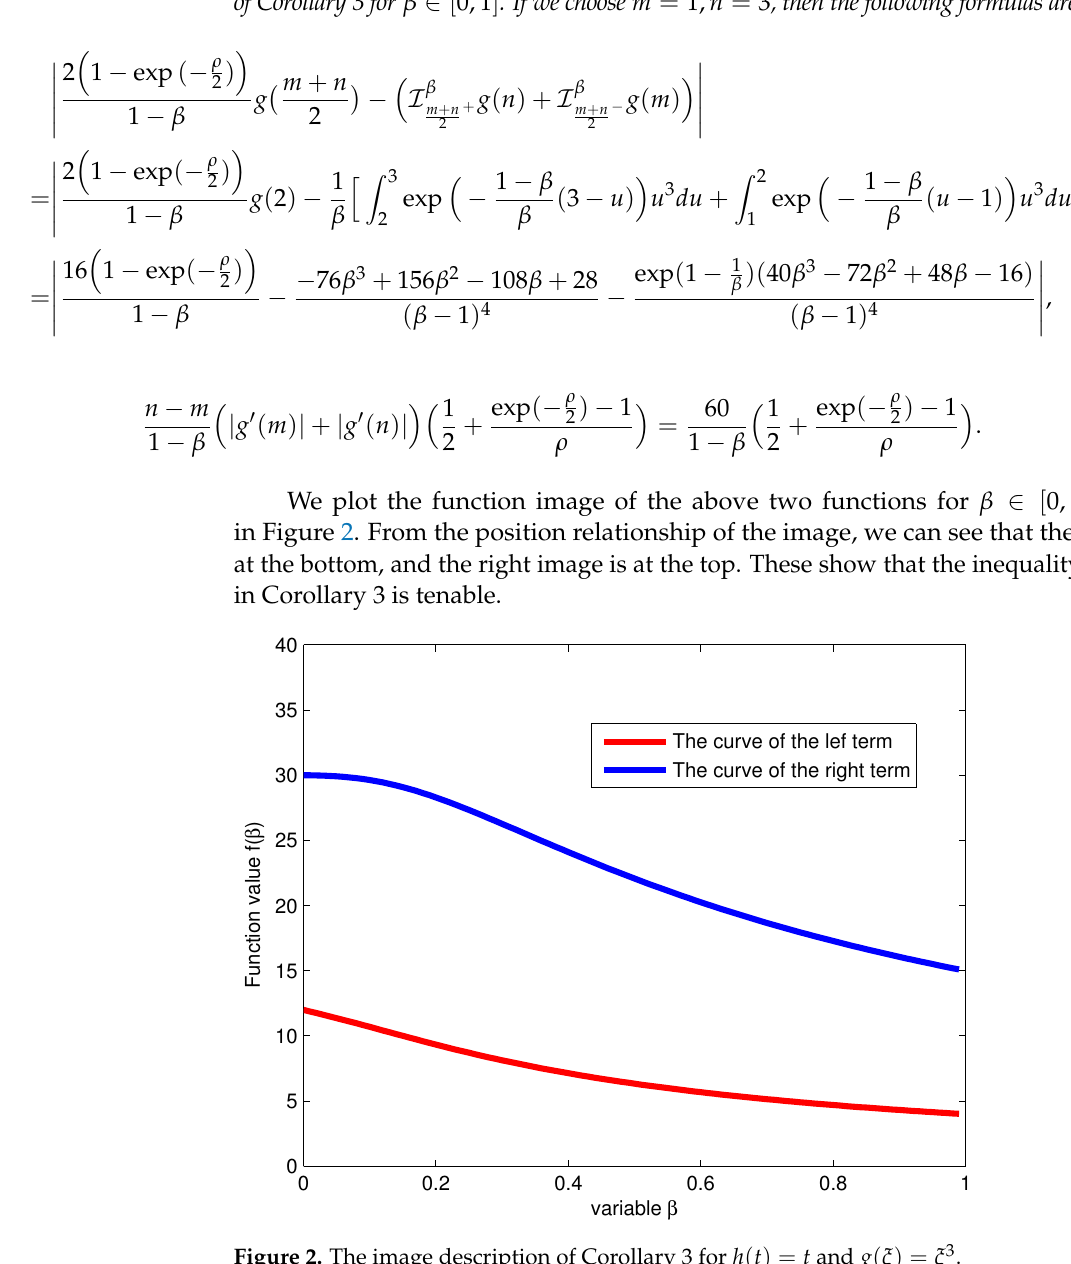
Figure 2. The image description of Corollary 3 for h ( t ) = t and g ( ξ ) = ξ 3